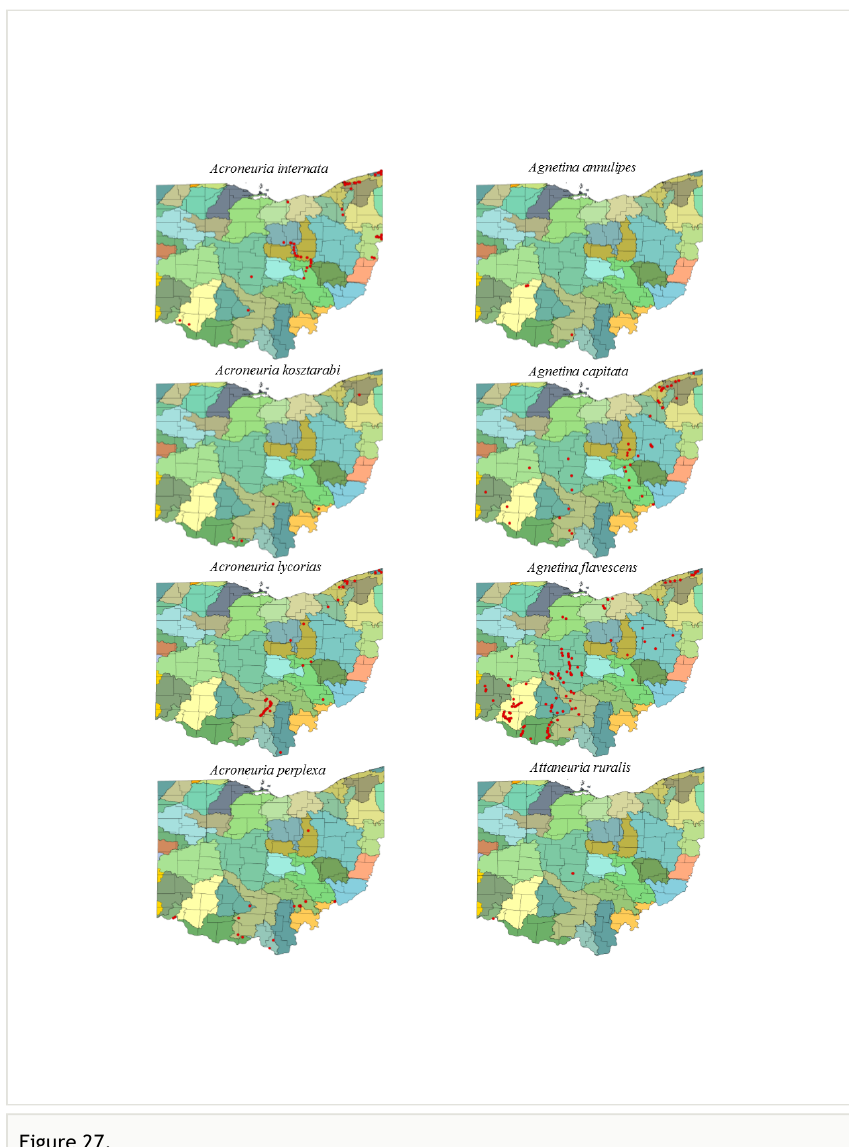
Figure 27. Distribution of Perlidae in